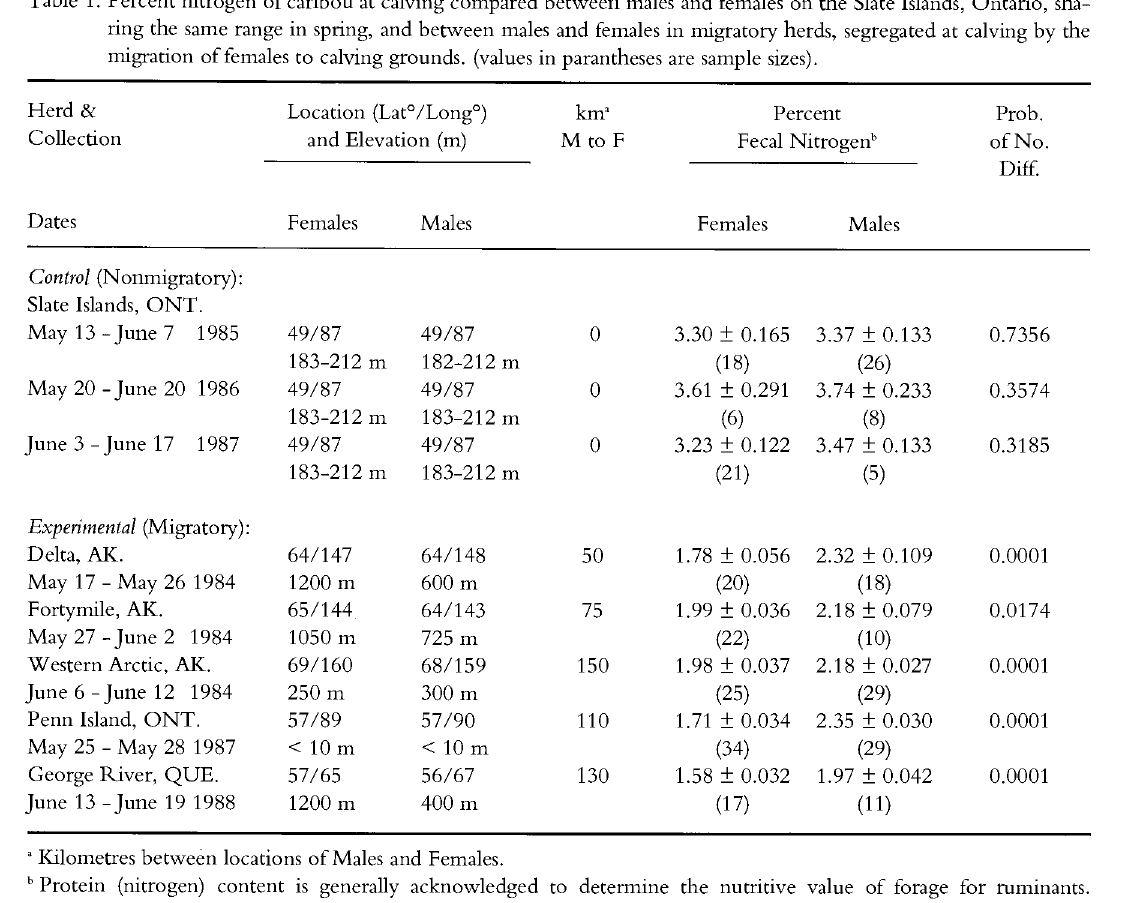
Table 1. Percent nitrogen of caribou at calving compared between males and females on the Slate Islands, Ontario, sha ring the same range in spring, and between males and females in migratory herds, segregated at calving by the migration of females to calving grounds, (values in parantheses are sample